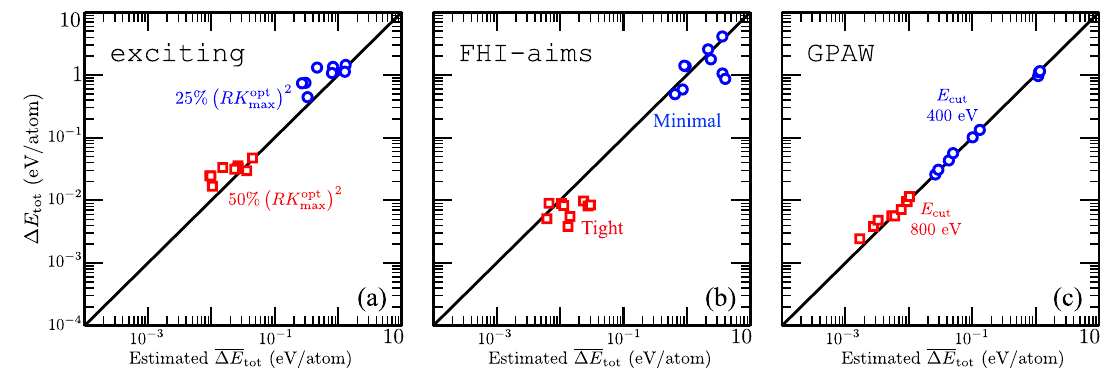
Fig. 4 Estimated vs. actual numerical error in the total energy of ternary systems. Two basis-set sizes were considered for each of the three employed codes, i.e., exciting ( a ), FHI-aims ( b ), and GPAW ( c ). Note that Ca 2 CdP, Na 2 IrZn, and Li 2 SnCl exhibit very similar errors and are thus not fully visible for all codes and levels of precision.